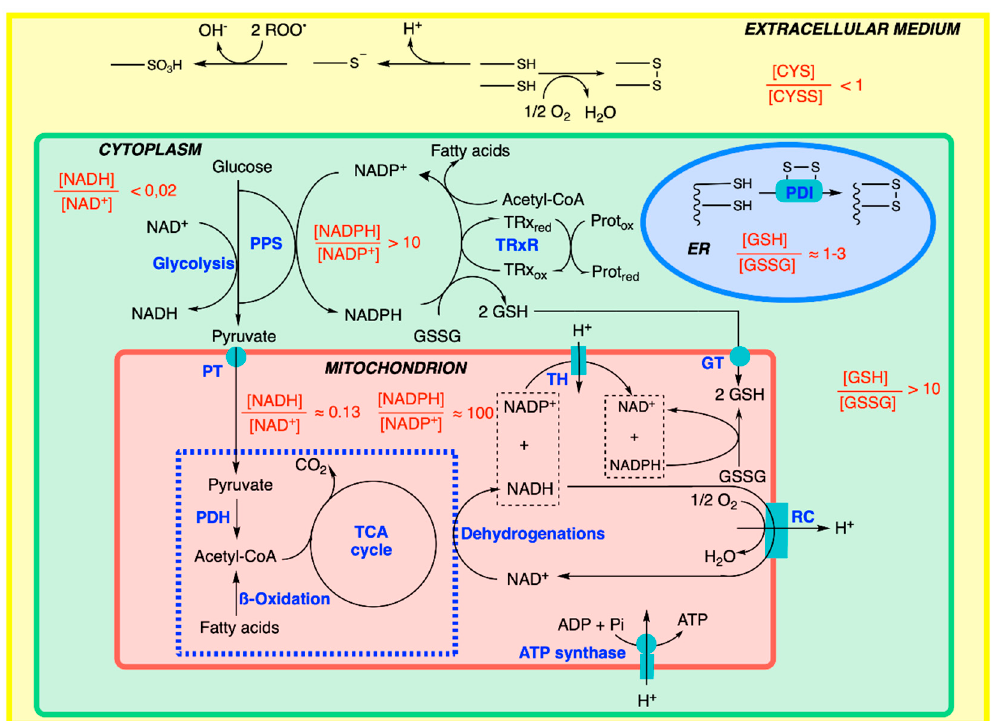
Figure 8. Redox and thiol balance in an animal cell. For explanations, see the text. RC, respiratory chain; GT, GSH carrier; PDH, pyruvate dehydrogenase complex; PDI, protein disulfide isomerase; PT, pyruvate transporter; ER, endoplasmic reticulum; PPS, pentose phosphate shunt; TH, H + -dependent transhydrogenase; TRx, thioredoxin; TRxR, thioredoxin reductase. The redox potential varies among the different cellular compartments: it is highest, far